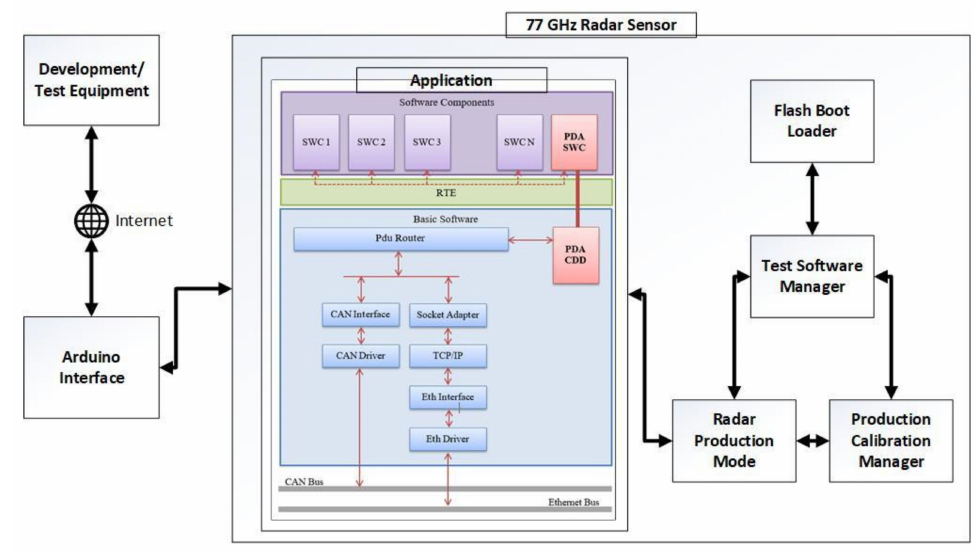
Figure 3. System